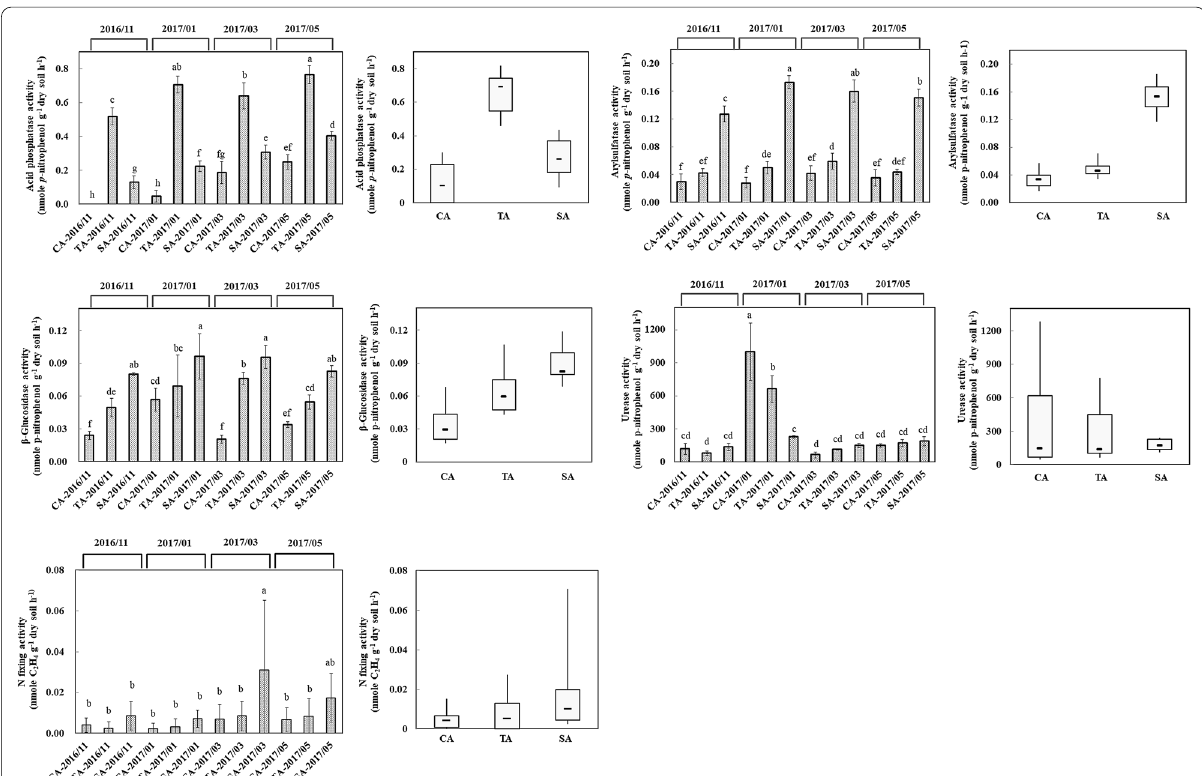
Fig. 4 Soil enzymatic activities of tea plantations. Acid phosphatase, arylsulfatase, and β ‑glucosidase activities were determined according to the p ‑nitrophenol method. The nitrogen‑fixing activity was determined by the acetylene reduction method using gas chromatography. Results are shown as mean standard deviation. The different letters labeled at columns are significantly different according to Duncan’s test (p < 0.05) ±